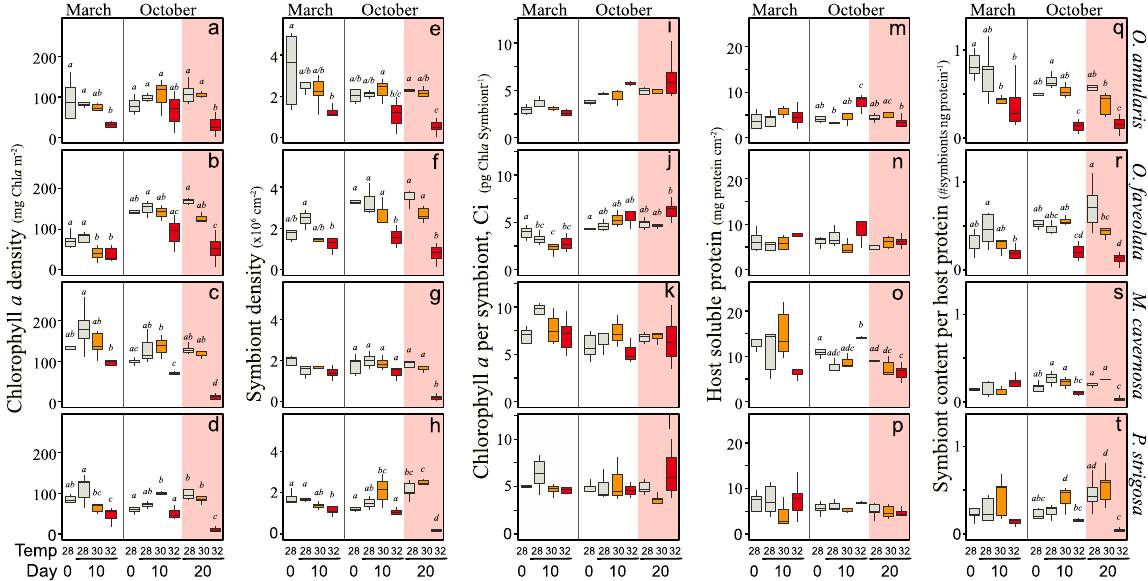
Figure 5. Response of coral structural descriptors to heat-stress. Box plots describing the variability of the structural descriptors for the four coral species investigated: Orbicella annularis , Orbicella faveolata , Montastraea cavernosa , and Pseudodiploria strigosa . Each plot describes coral responses in March (winter phenotype) and October (summer phenotype) after 10 days (white area) and 20 days (red area) of exposure to control (28 °C; grey), and heat-stress conditions of + 2 °C (30 °C; orange), and + 4 °C (32 °C; red). Boxes encompass the 25 and 75% quartiles of all the data (n = 5). The central line corresponds to the median, and bars extend to the 95% and 5% of confidence limits. Letters mark significant differences (Tukey Post-Hoc test, p < 0.05) between treatments within a